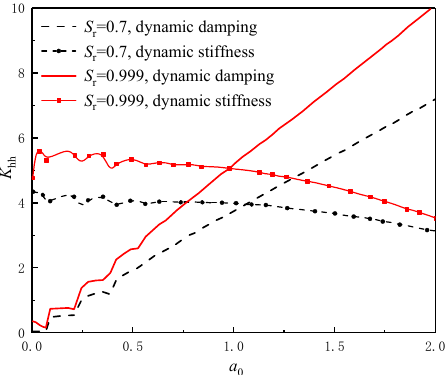
Figure 12. Influence of saturation of unsaturated soil on the dynamic horizontal impedance of the pile (reproduced from Zhang et al. (2019) [119]).